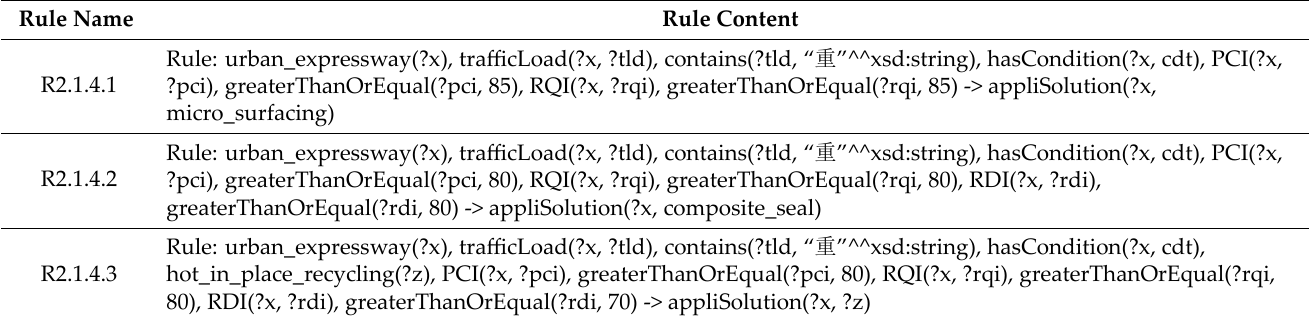
Table 8. Renewal rules for expressways with aging asphalt and severe traffic load.